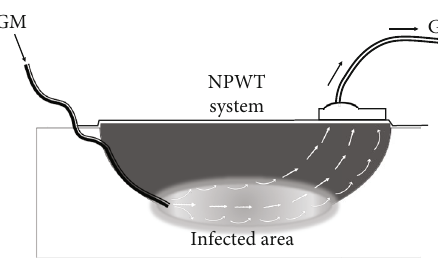
Figure 1: The schema of continuous local antibiotic perfusion (CLAP) therapy. A high concentration of gentamicin solution injected from the inlet tube into the infected area is perfused by the negative pressure wound therapy (NPWT) system. GM: